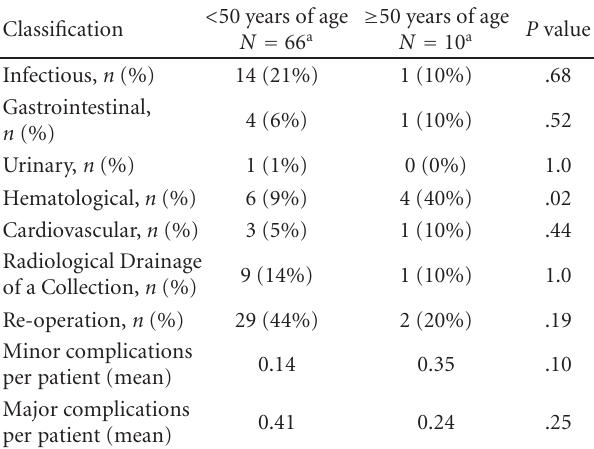
Table 3: Distribution of surgical complications.